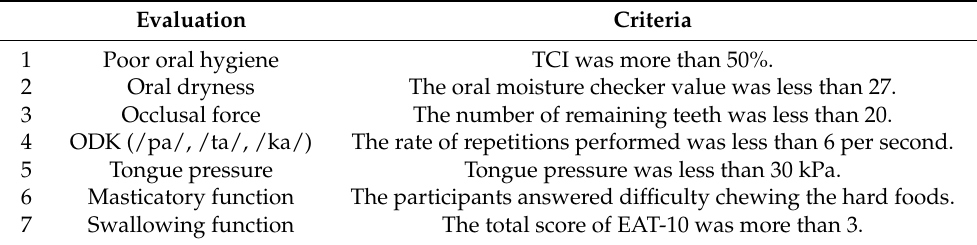
Table 1. The seven-item evaluation for diagnosis of oral hypofunction in this study.